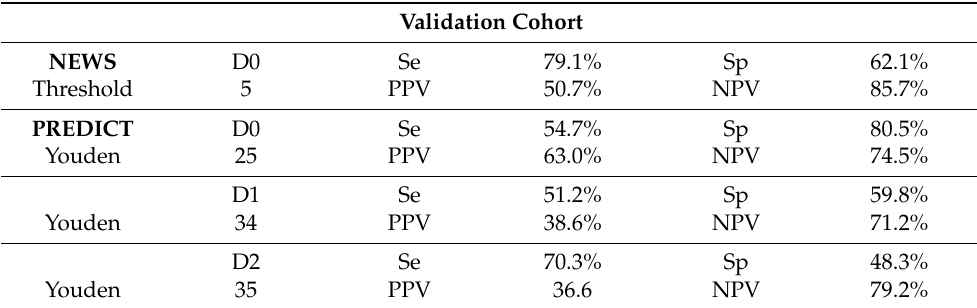
Table 9. PREDICT and NEWS2 score characteristic comparison for validation cohort. Se: sensitivity; Sp: specificity; PPV: Positive Predictive Value; NPV: Negative Predictive Value.